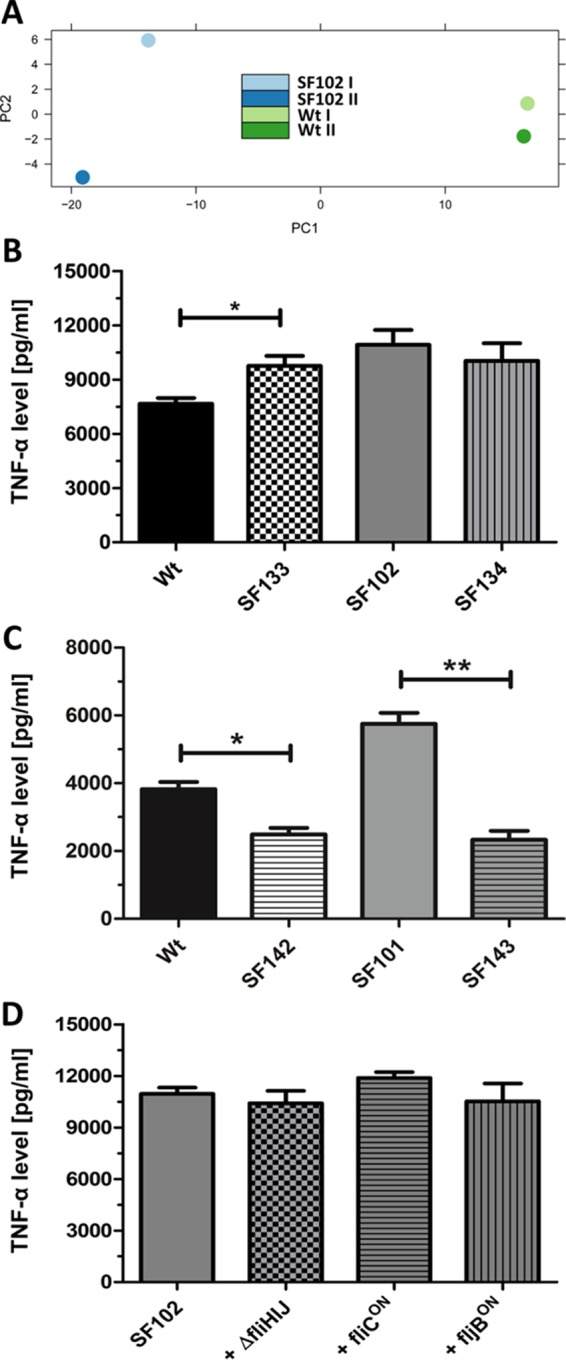
In vivo transcriptome analysis of Wt and SF102 (ΔlpxR9 ΔpagL7 ΔpagP8 ΔaroA). (A) Principal component analysis. (B) TNF-α levels in the sera of mice infected with Wt, SF102 (ΔlpxR9 ΔpagL7 ΔpagP8 ΔaroA), SF133 (ΔarnT::FKF), or SF134 (ΔlpxR9 ΔpagL7 ΔpagP8 ΔaroA ΔarnT::FKF) 1.5 h postinfection. (C) TNF-α levels in the sera of mice infected with Wt, SF101 (ΔaroA), SF142 (ΔansB::FKF), or SF143 (ΔaroA ΔansB::FKF). (D) Effect of flagellar phenotype on TNF-α induction. The means with standard deviations are displayed. Results are representative for two independent experiments with 5 replicates per group. *, P < 0.05; **, P < 0.01.